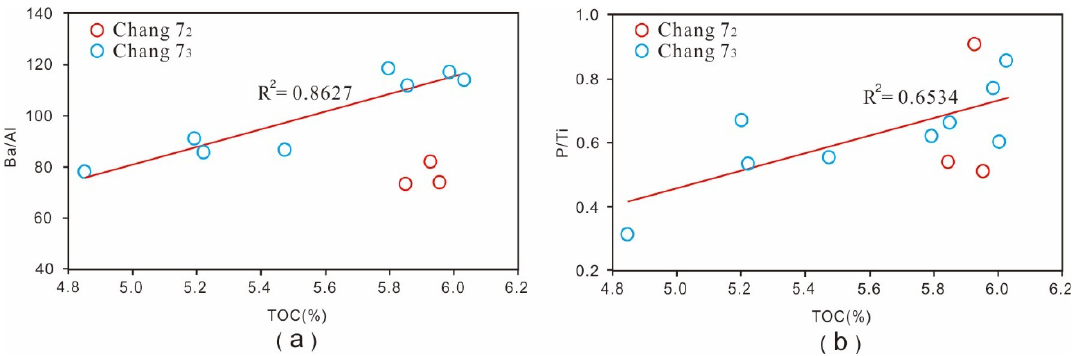
Figure 4. The cross-plot of biological productivity indicators and TOC: ( a ) Relationship between Ba/Al and TOC; ( b ) Relationship between P/Ti and TOC.